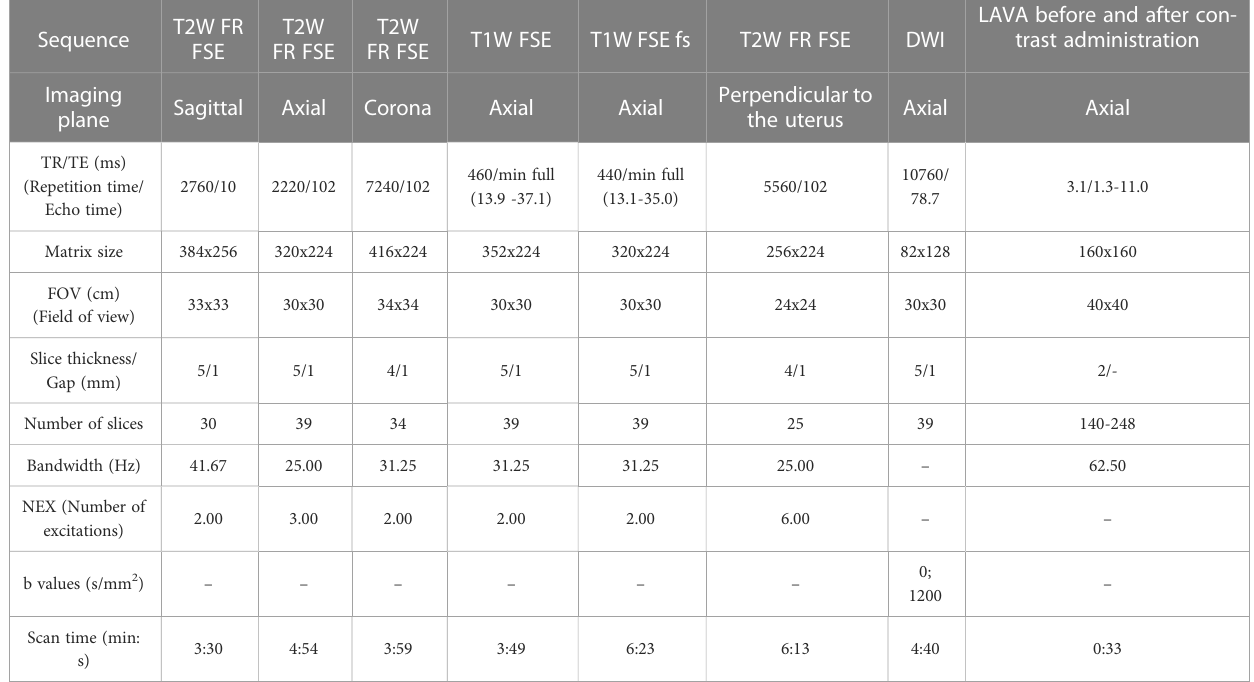
Table 1. To prepare for the examination, patients fasted between 3 and 6 hours (except those with diabetes). Patients received an intramuscular injection of antiperistaltic agent hyoscine butylbromide (Buscopan ampoule 20 mg) to decrease artifacts